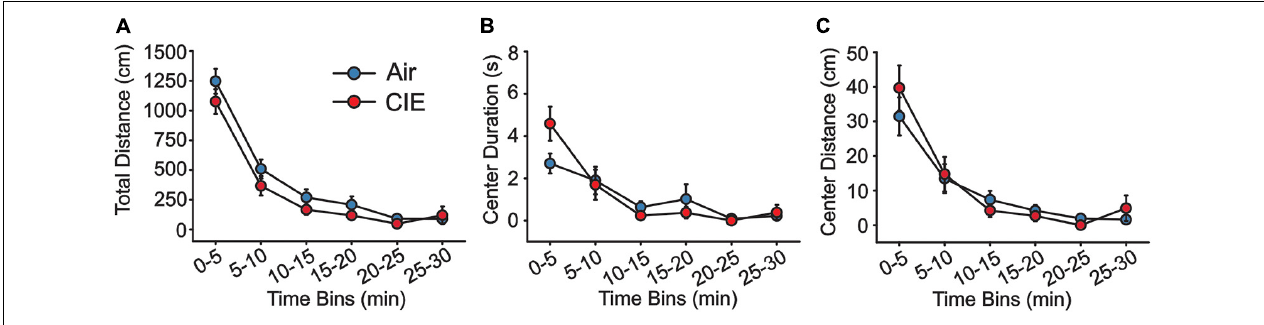
FIGURE 2 | There is no evidence of CIE-induced anxiety-like behavior on the OFT. Air ( n = 12) and CIE-treated rats ( n = 12) showed no differences in (A) the total distance traveled, (B) the amount of time spent, or (C) in the distance traveled in the center of the arena. All data are expressed as the mean ±